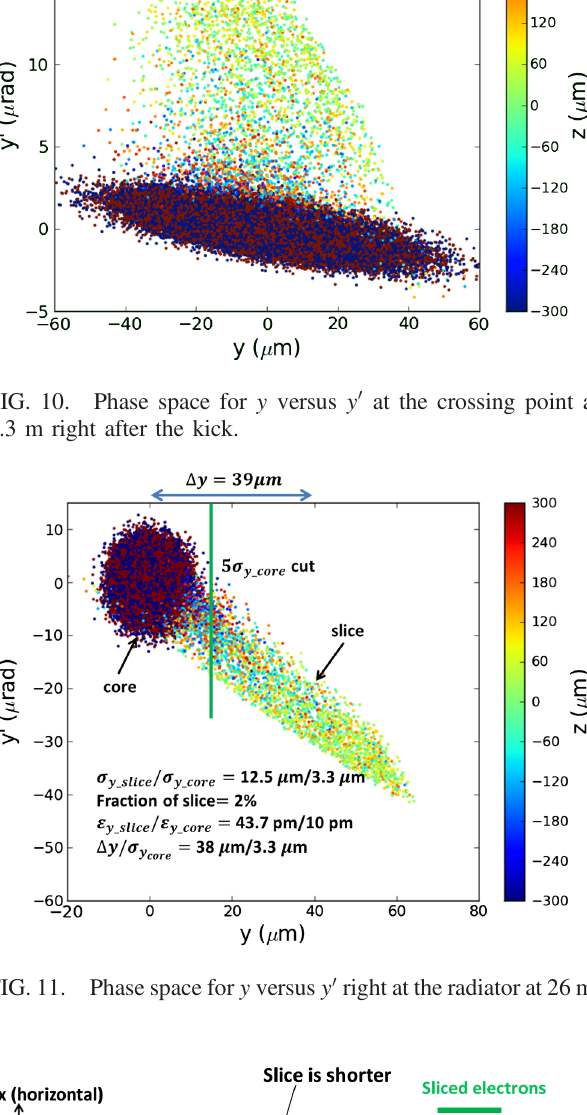
FIG. 12. Illustration of using 45° crossing to reduce crossing time and reduce the slice pulse